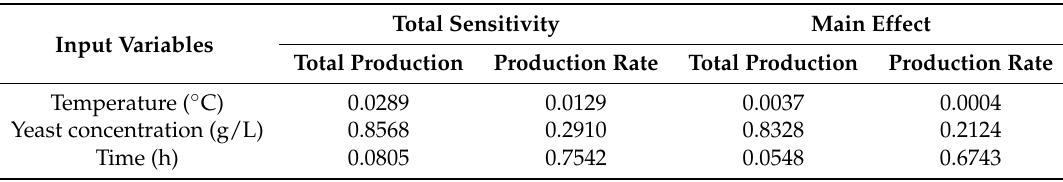
Table 6. Sensitivity analysis of the independent variables on total ethanol production and ethanol production